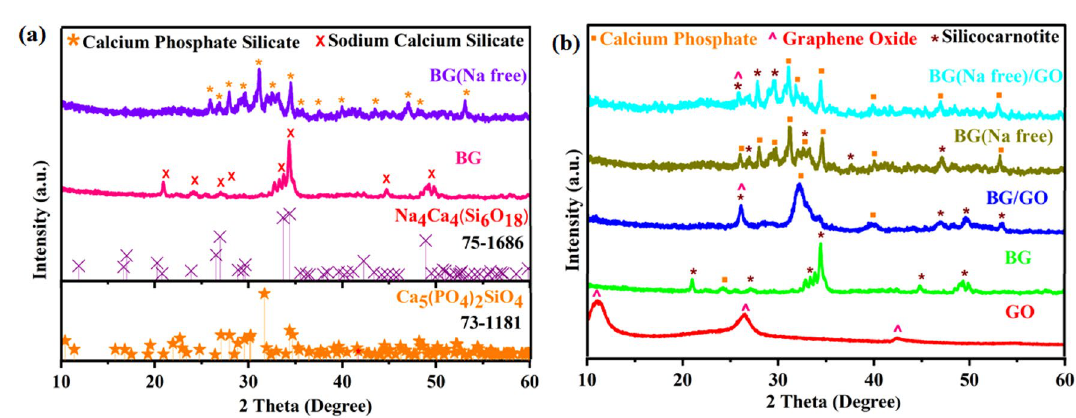
Figure 13. XRD patterns for ( a ) BG and BG (Na-free), ( b ) BG, BG (Na-free), GO and BG/GO, and BG (Na-free)/GO development of the BG-GO matrix, the XRD patterns of the BG/GO and BG (Na-free)/GO nanocomposites exhibit changed crystal orientation. The GO (001), (002), and (100) planes appeared at the 2θ values of 11.09°, 26.47°, and 42.° respectively. Furthermore, due to the inclusion of oxygen functional groups from GO, the BG/ GO nanocomposite has a higher intensity than BG were displayed in Fig. 13b. The reduced graphene oxide (rGO) signal produced at 42° confirmed an expansive and amorphous character. Compared to BG (Na-free), the nanocomposite BG (Na-free)/GO exhibits a two-fold increase in intensity and a peak shift. Similarly, the BG/ GO nanocomposite exhibits peak widening and shifts a twofold reduction in intensity. The calcium phosphate